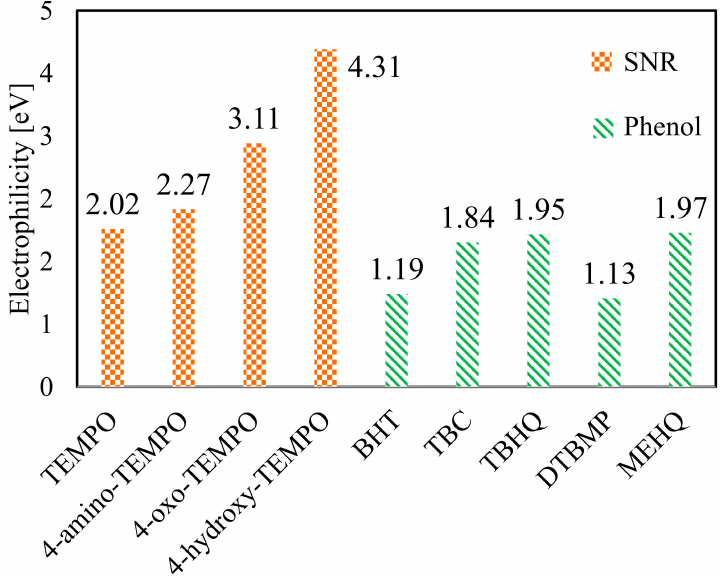
Figure 7. Calculated electrophilicity of SNRs and phenolics utilizing density functional theory